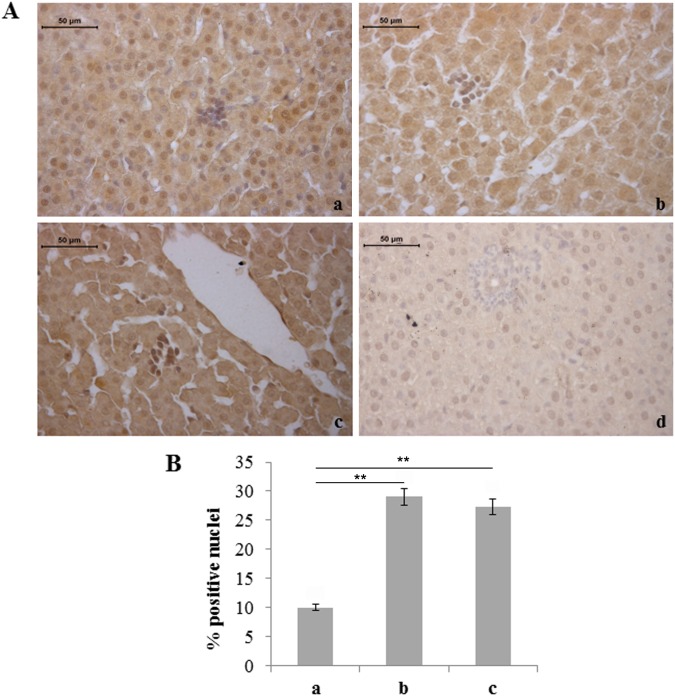
Moderate and severe hyperoxia increases VEGF expression in liver haemopoietic foci.A) Immunohistochemical detection of VEGF-positive haemopoietic cells in neonatal rat livers exposed to moderate and severe hyperoxia. a) ambient air; b) 60% hyperoxia; c) 95% hyperoxia; d) negative control; scale bar: 50 µm, magnification 40x. B) Graphic representation of VEGF-positive haemopoietic cells percentages (±SD); densitometric analysis determined by direct visual counting of ten fields for each of three slides per sample. ** = p<0.01.